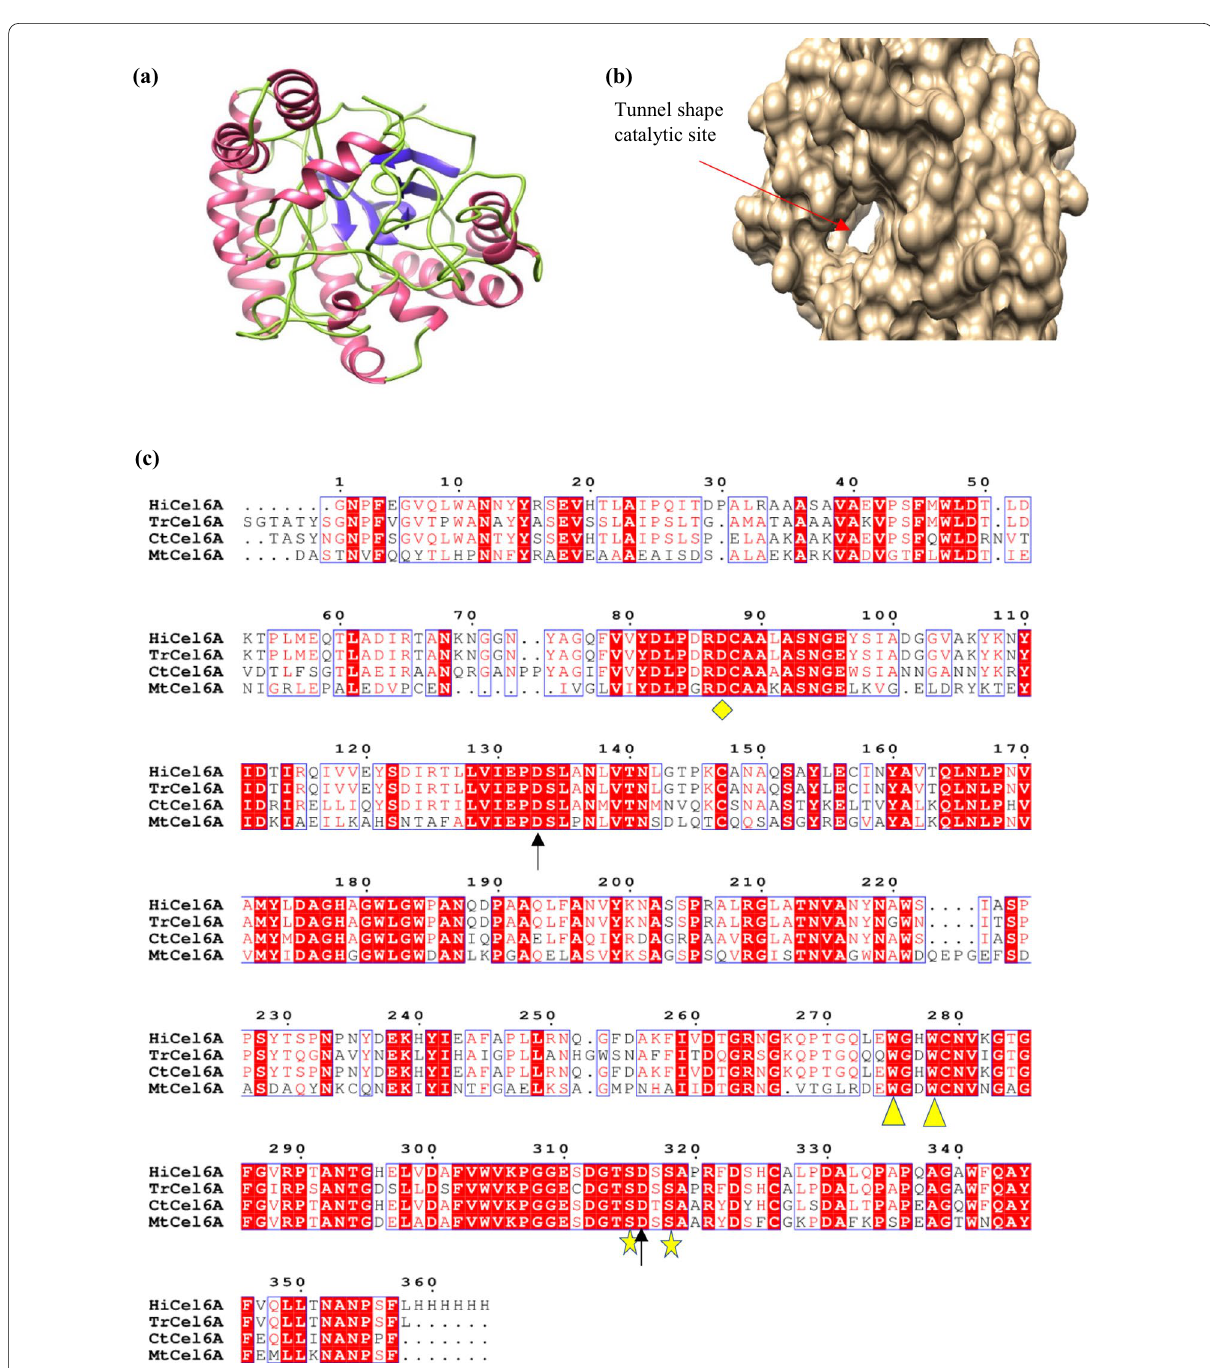
Fig. 1 a 3D model of MtCel6A; where α-helix, β-sheets and loops are highlighted in purple, blue and green, respectively. b 3D structure showing tunnel shape catalytic site. c Multiple sequence alignment of MtCel6A showing conserved critical amino acid residues; Asp 128 (catalytic acid) and Asp 314 (catalytic base) are marked with arrows, and other key residues (described in text) are marked with yellow diamond, triangle, and